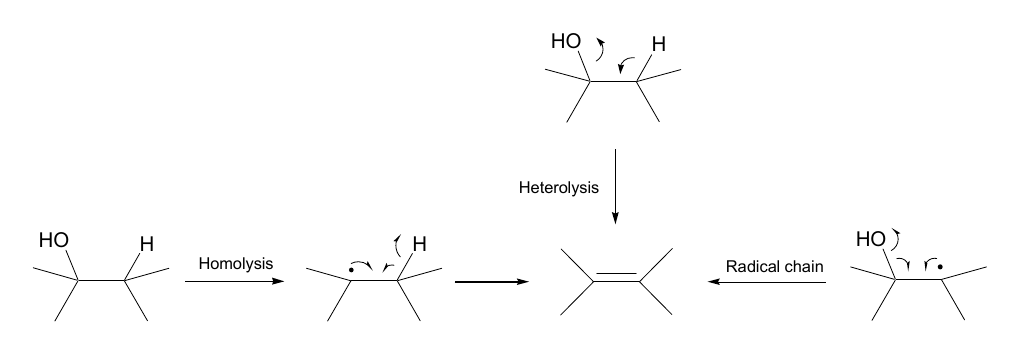
Figure 8. Three possible dehydration pathways for polyalcohols.